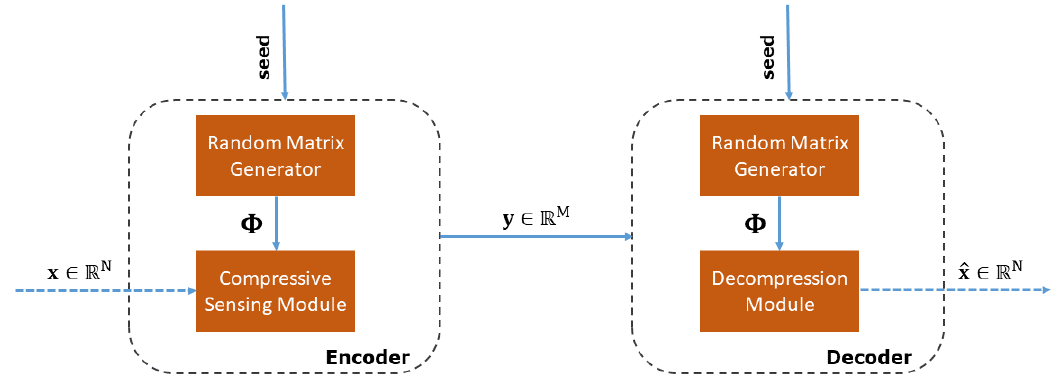
Figure 3. General architecture of our CS-based system.